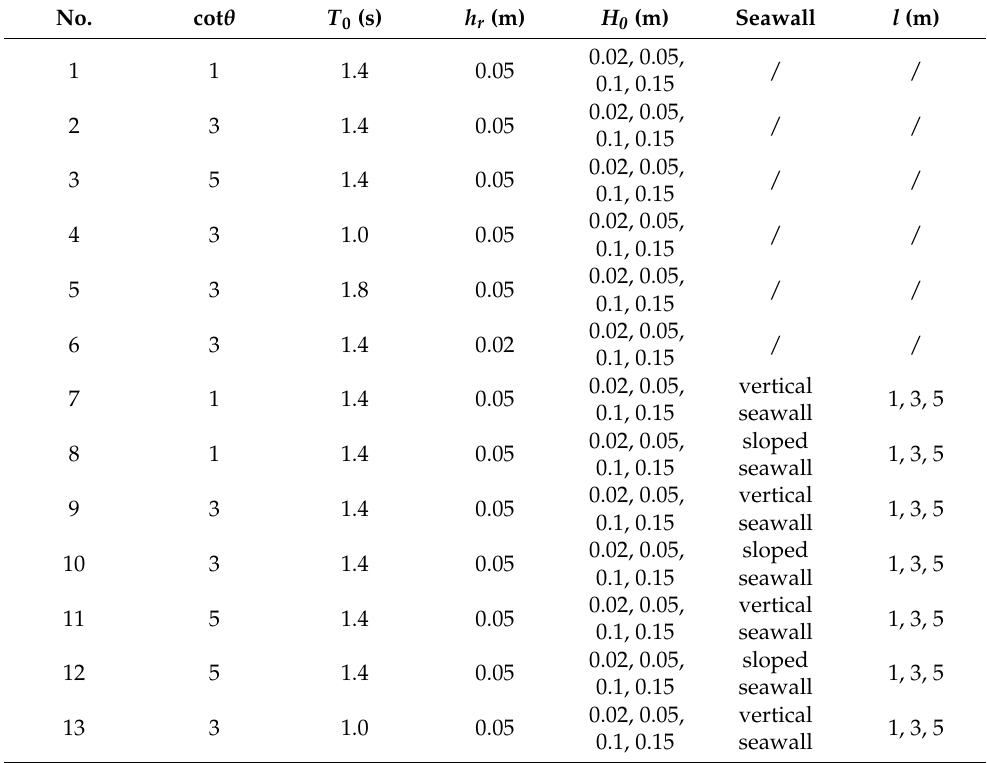
Table 1. Experimental test cases for the regular wave acting on the seawall.